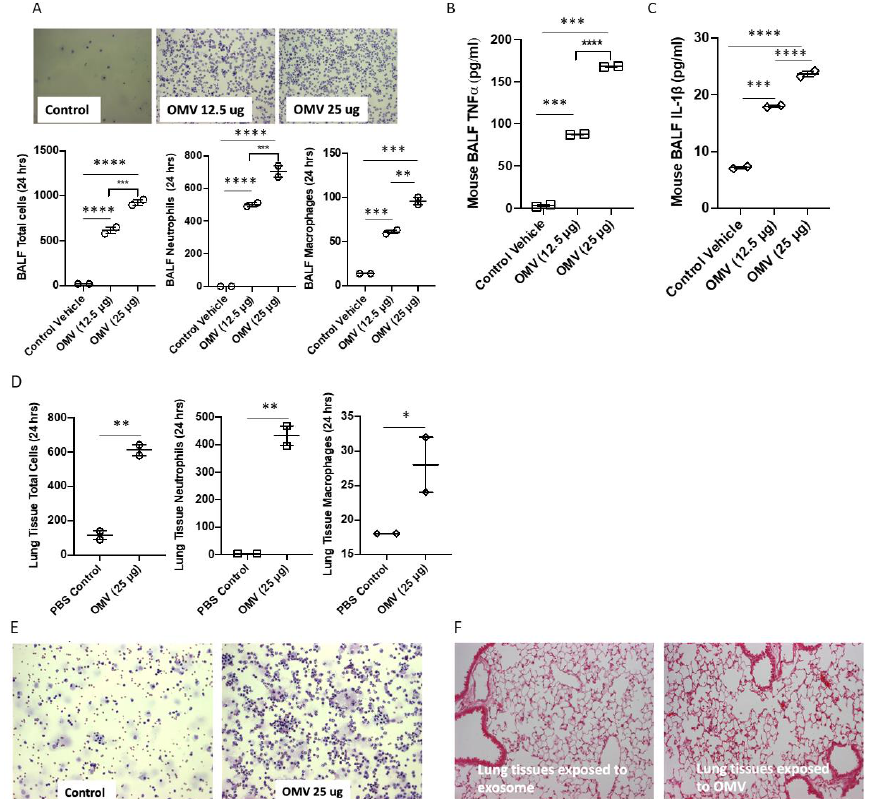
Figure 3. OMVs induced inflammatory lung responses. ( A ) Mice were exposed to different doses of OMVs. After 24 h, BALF were collected, and cells in BALF were stained using H&E staining. The total cell counts (left, lower panel), neutrophil counts (middle, lower panel), and macrophage counts (right, lower panel) were shown. ( B , C ) The TNF- α ( B ) and IL-1 β ( C ) were determined in BALF using ELISA. ( D ) Effects of OMVs (25 µ g/mL) on total cell counts infiltrating the lung tissues (left), on neutrophil counts (middle), and macrophage counts (right). ( E , F ) Mice were treated with OMVs (25 µ g/mL) i.t., after 24 h, cells infiltrating lung tissue ( E ) were stained using H&E staining; Lung tissue ( F ) was also stained using H&E staining. Results were expressed as mean ( n = 2 individual experiments) ± SD. Statistical Analysis was performed non-parametrically using the One-way Analysis of variance (ANOVA) with Tukey’s multiple comparison tests to determine significant differences between the experimental groups. * p ≤ 0.005 ** p ≤ 0.001, *** p ≤ 0.0005, **** p ≤ 0.001 vs. the control (PBS treated) or 12.5 µ g OMV treatment